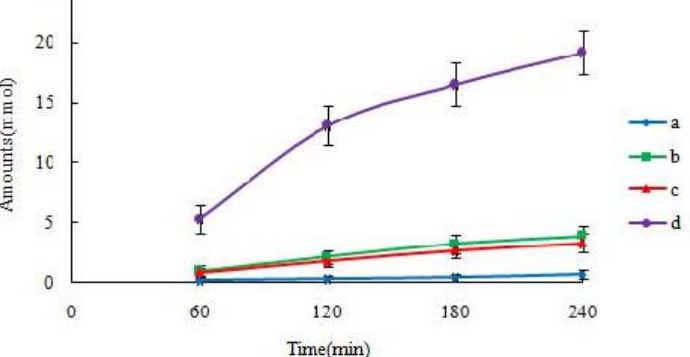
Figure 3. The transportation of icariin as time changes. Cumulative amounts of icariin transported across Caco-2 cell monolayers. The cumulative amount transported at each time point using the Kruskal–Wallis test followed by Tamhane’s post hoc was used to analyze the data statistically, n = 3. ( a : 20 μ M icariin + DOC A-B; b : 20 μ M icariin + DOC B-A; c : 20 μ M